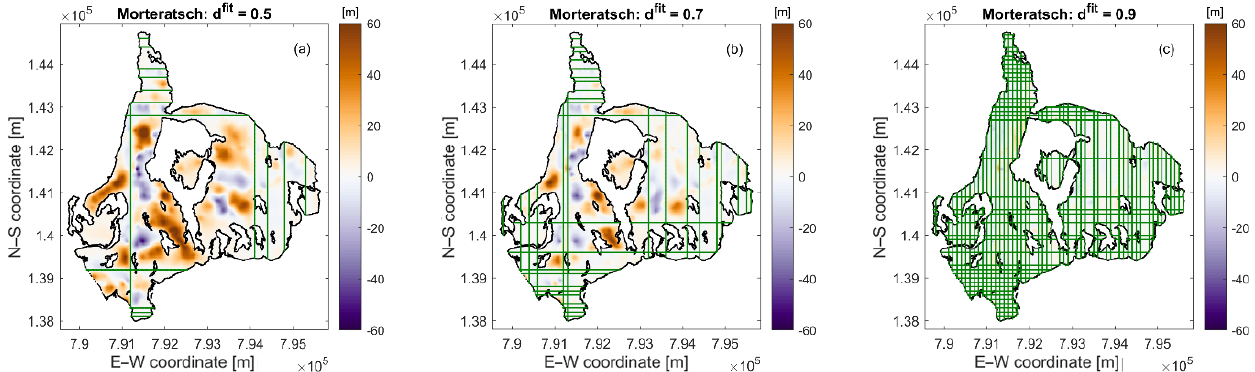
Figure 9. Vadret da Morteratsch model misfit h true − h est k after selected stages of the experimental design procedure using synthetic data (see also vertical dashed lines in Fig. 5). The selected GPR profiles are superimposed with green lines.